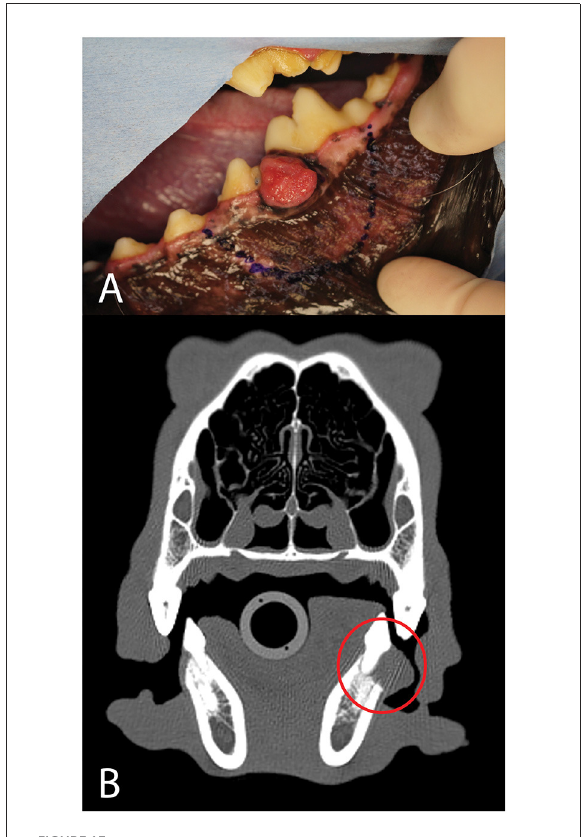
FIGURE13 Photograph (A) and axial CT image (B) of the neoplasm (red circle) in case 4.